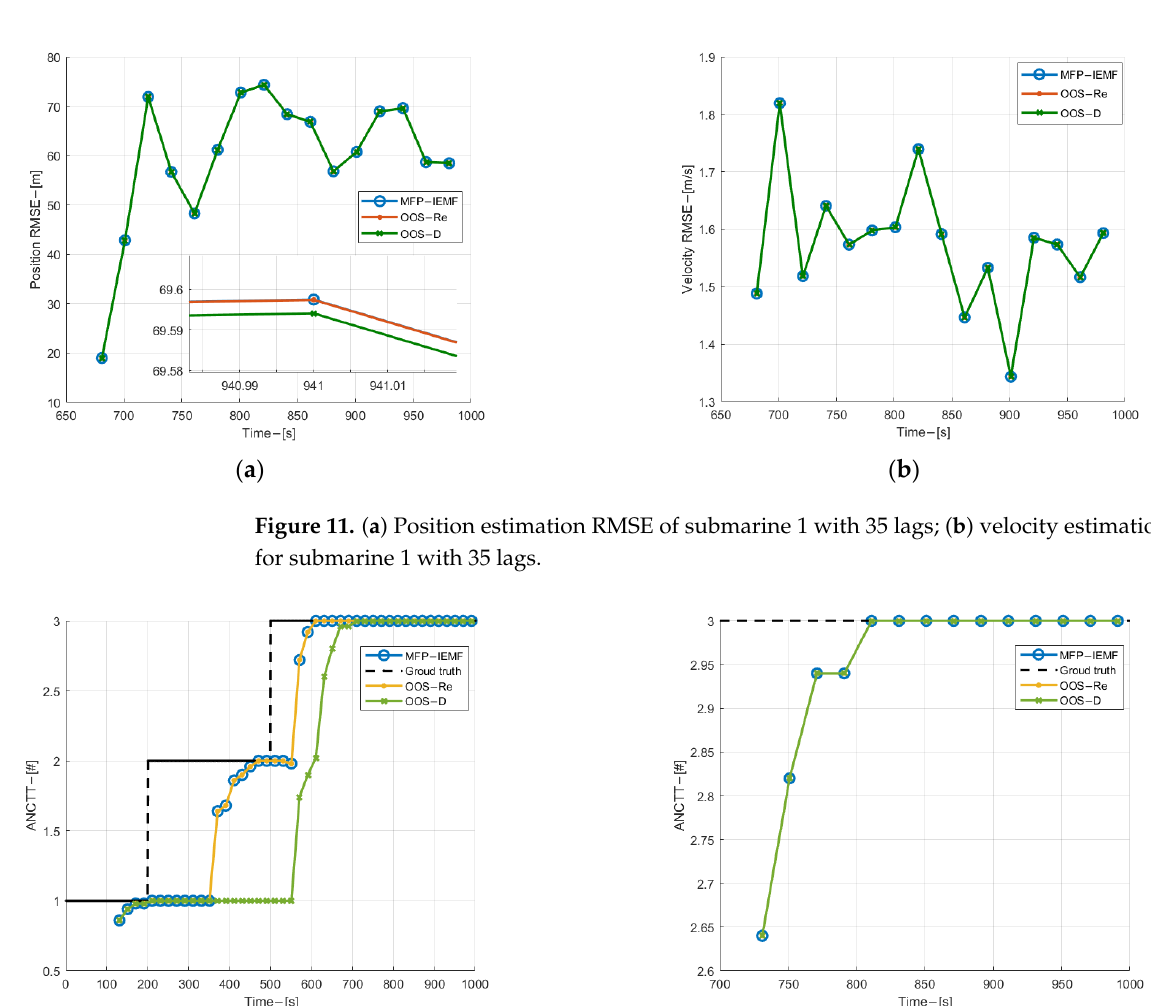
Figure 10. ( a ) Position estimation RMSE of submarine 1 with 5 lags; ( b ) velocity estimation RMSE for submarine 1 with 5 lags.